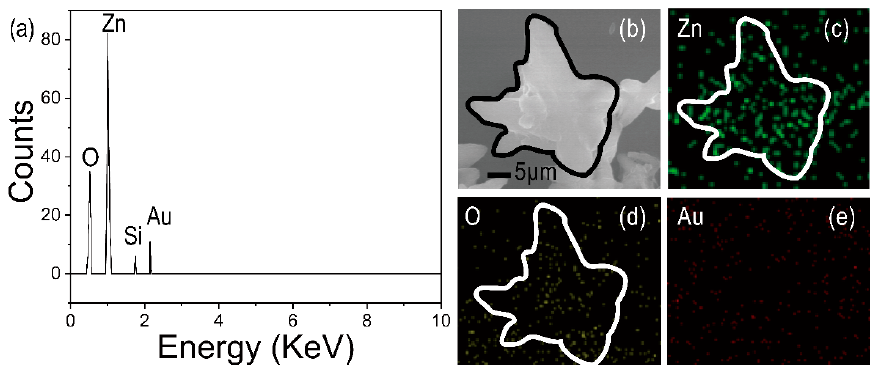
Figure 3. Elemental analysis. ( a ) EDS spectrum of ZnO nanoflowers/Au structure. ( b ) Enlarged view of ZnO nanoflowers/Au structure. ( c ) Elemental mapping of ZnO nanoflowers/Au structure: Zn, O ( d ) and Au ( e ).